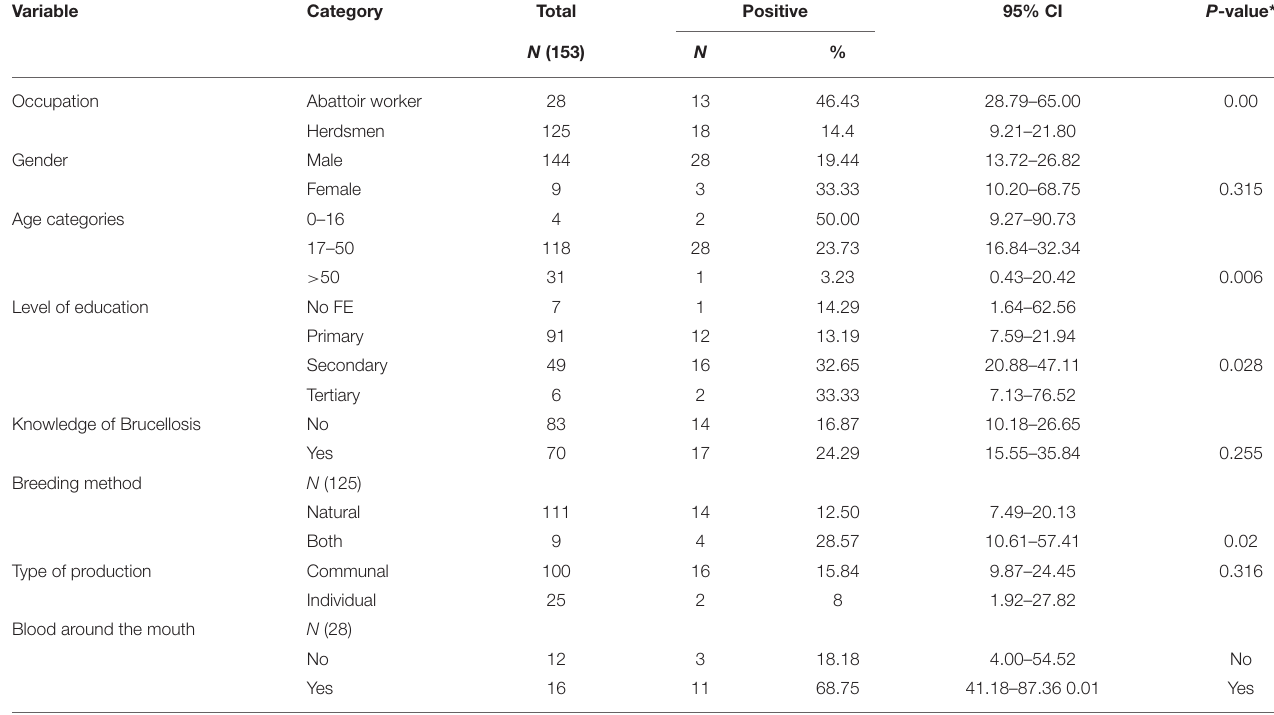
TABLE 3 | Univariate analysis for predicators of brucellosis among herdsmen and abattoir workers.